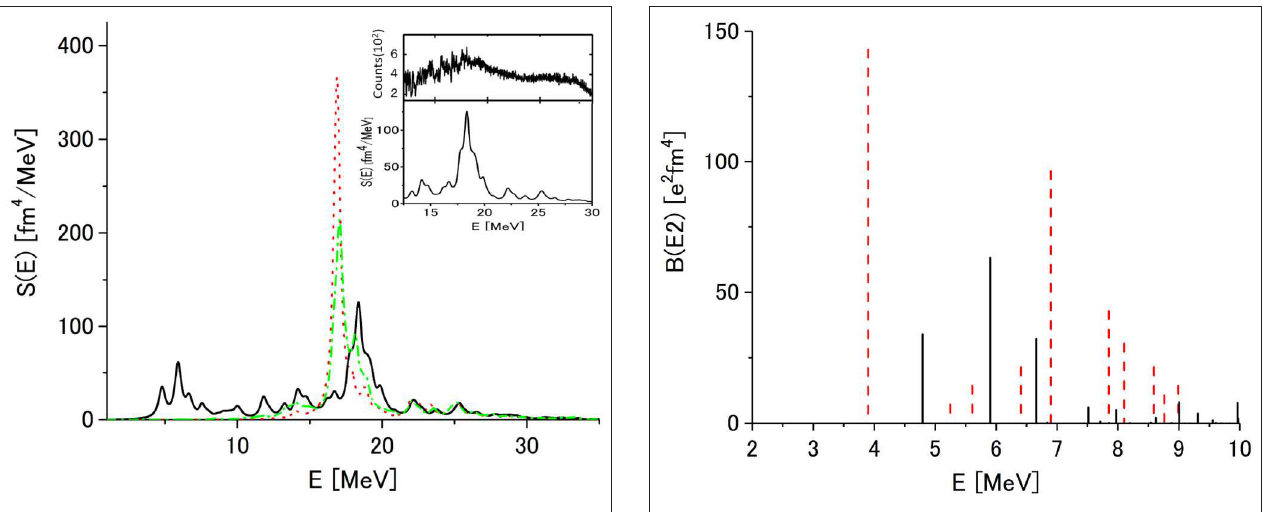
FIGURE 11 | Distribution of B ( E 2) strength below 10 MeV for 40 Ca. Experimental data (dashed line) are taken from Hartmann et al. [ 54]. 0.5 MeV. In = 200 MeV and θ Lab 11 ◦ = =